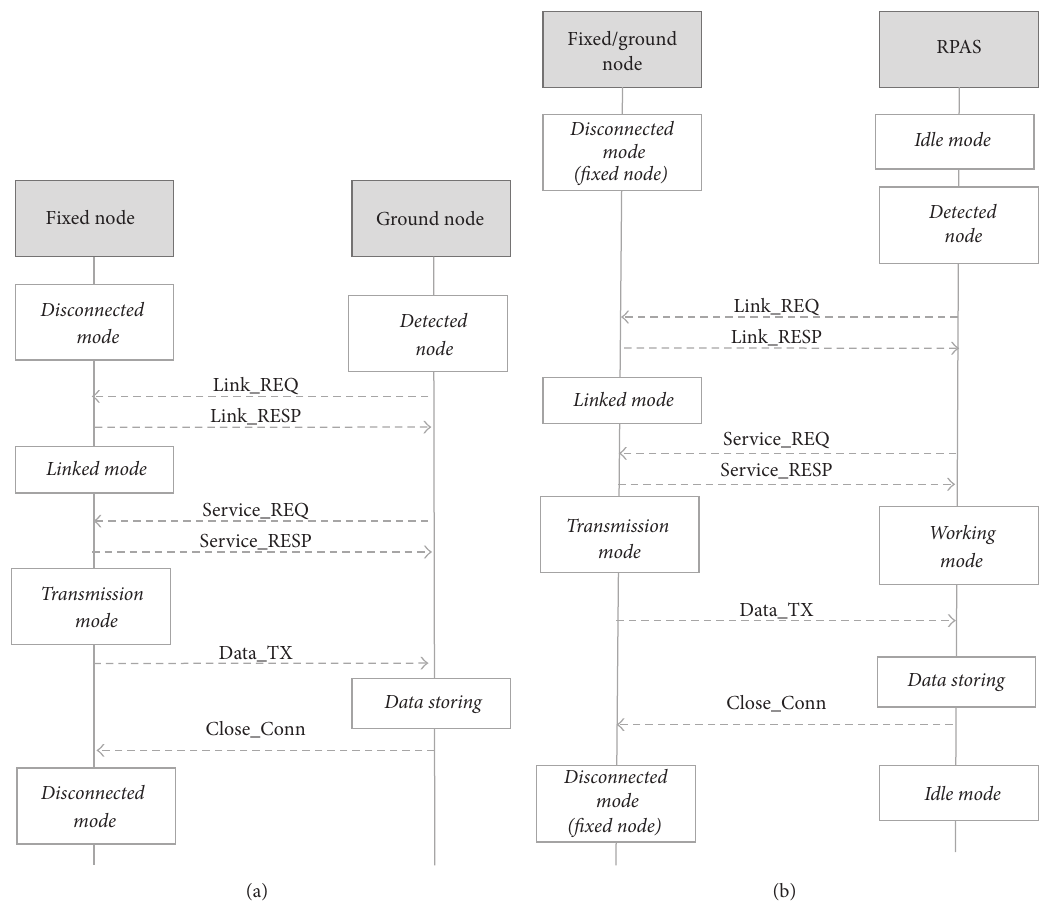
Figure 3: Operating modes: (a) fixed-ground and (b) fixed/ground and RPAS.